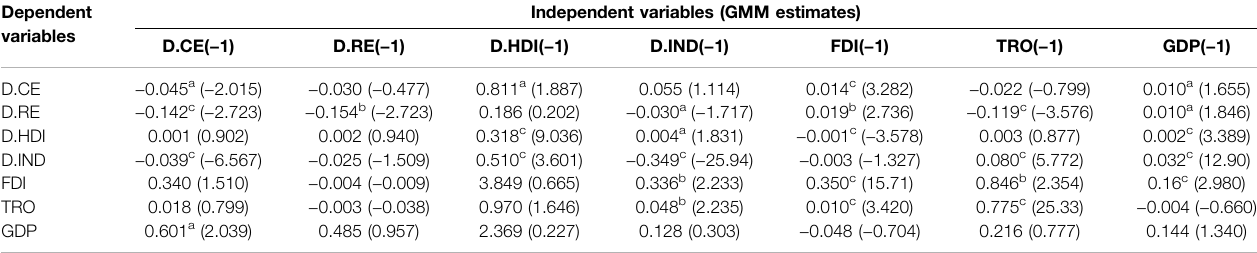
TABLE 10 | Panel VAR model estimation results for lower middle − income countries. Dependent